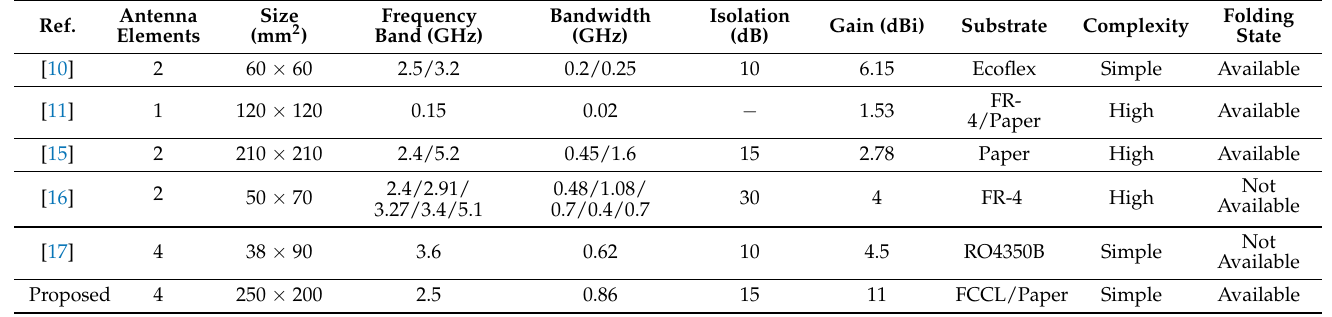
Table 2. Comparison between the proposed and previously presented Kirigami and Origami antennas.